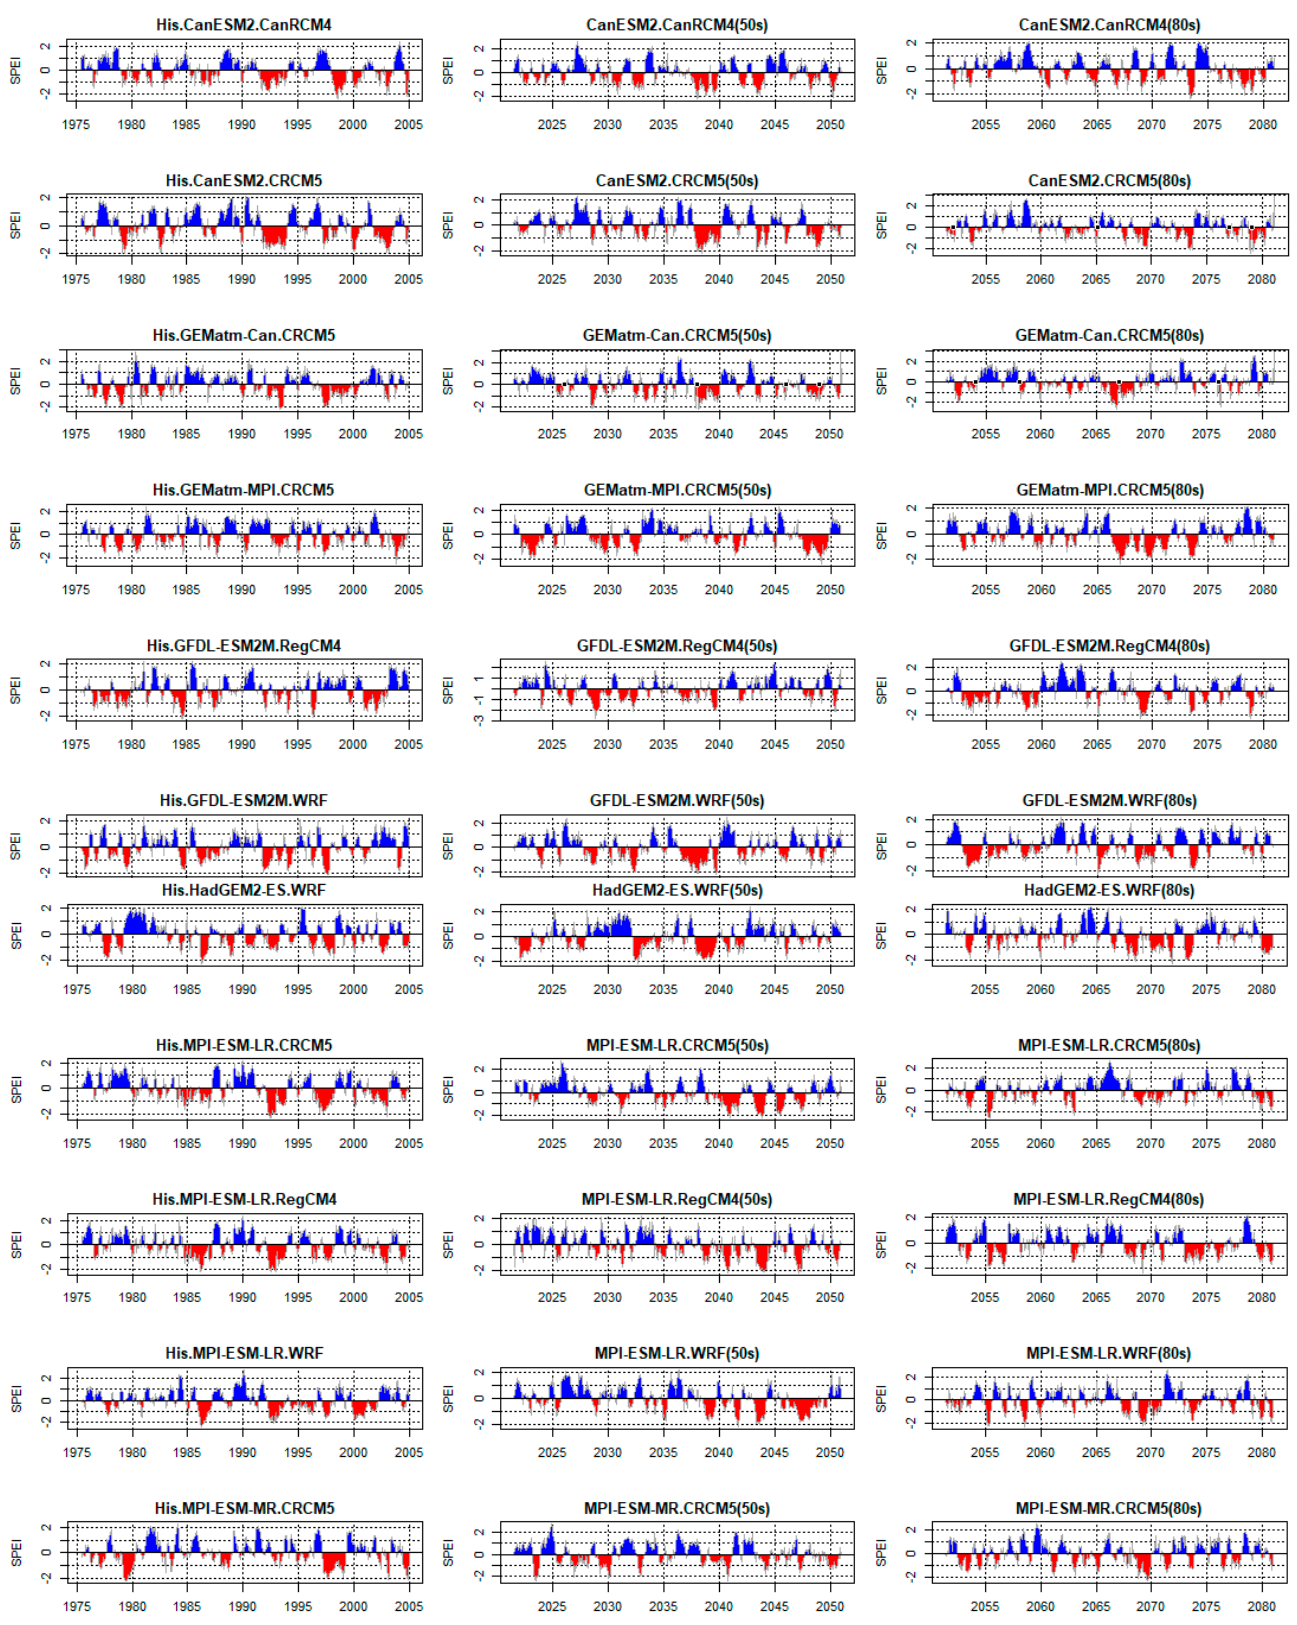
Figure 7. Temporal variation of SPEI at 6-month scale under historical and projected changes.